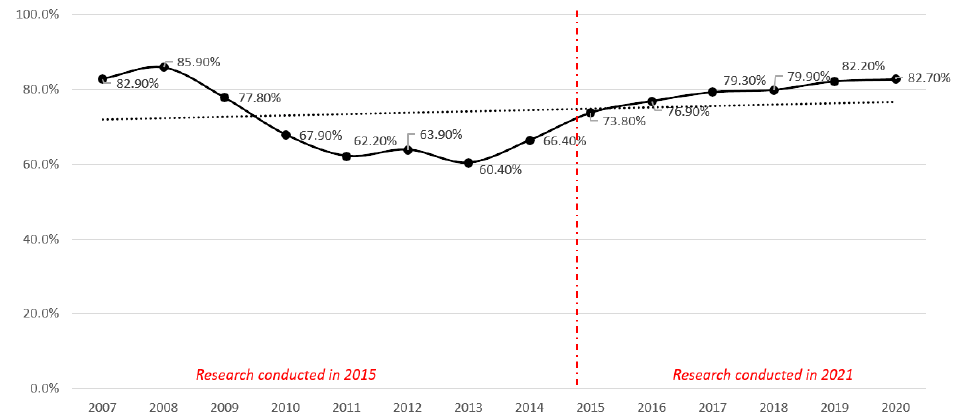
Figure 1. Effectiveness of achieving environmental objectives in each calendar year.